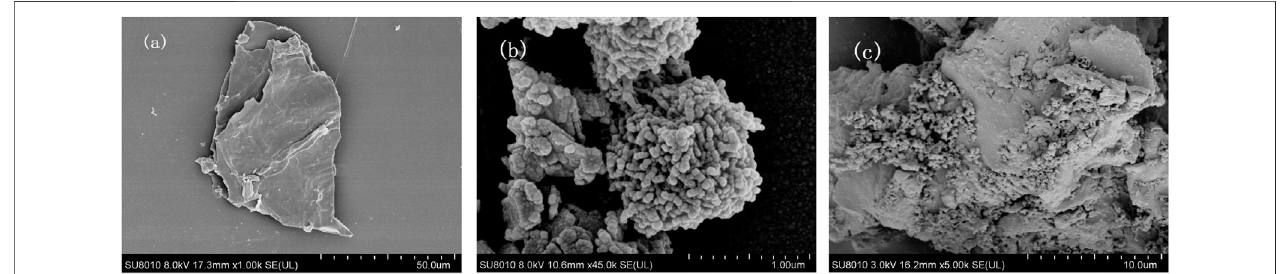
FIGURE 1 | SEM images of BC (A) , nZVI (B) , nZVI/BC (C) .